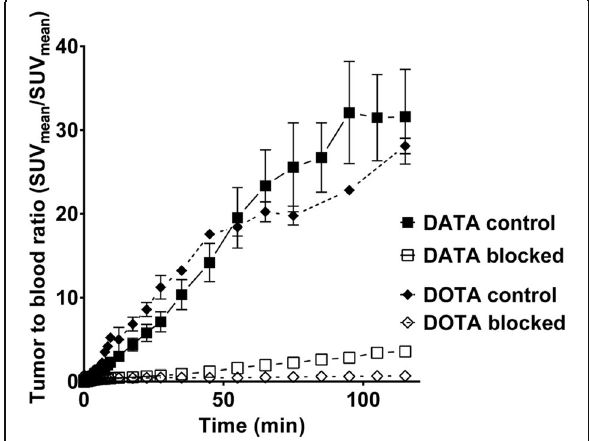
Fig. 4 Tumour-to-blood ratios of [ 68 Ga]Ga-DATA-TOC and [ 68 Ga]Ga- DOTA-TOC calculated from dynamic PET studies with two animals per group (values are mean ±